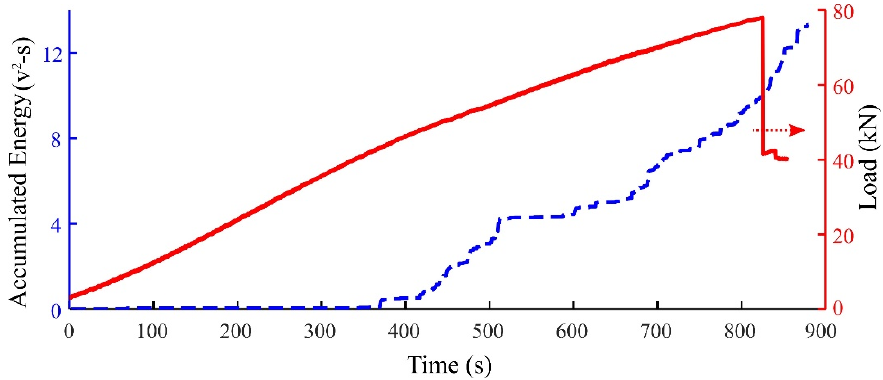
Figure 2. Temporal evolution of AE hits energy against applied load for a CFRP size 2 specimen.